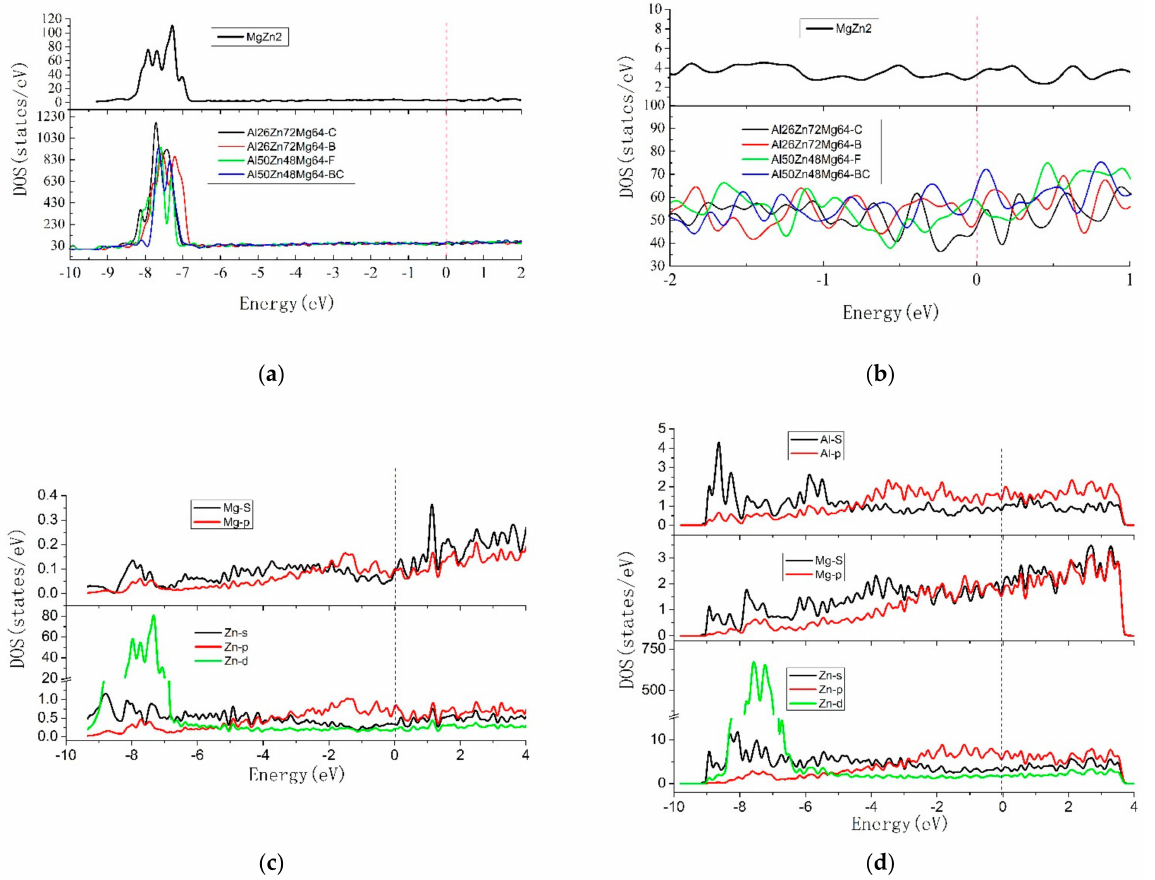
Figure 2. The DOS diagrams: ( a ) TDOS from − 10 to 2 ev of MgZn 2 and T-phases; ( b ) TDOS from − 4 to 2 ev of MgZn 2 and T-phases; ( c ) PDOS of MgZn 2 ; ( d ) PDOS of Al 26 Zn 72 Mg 64